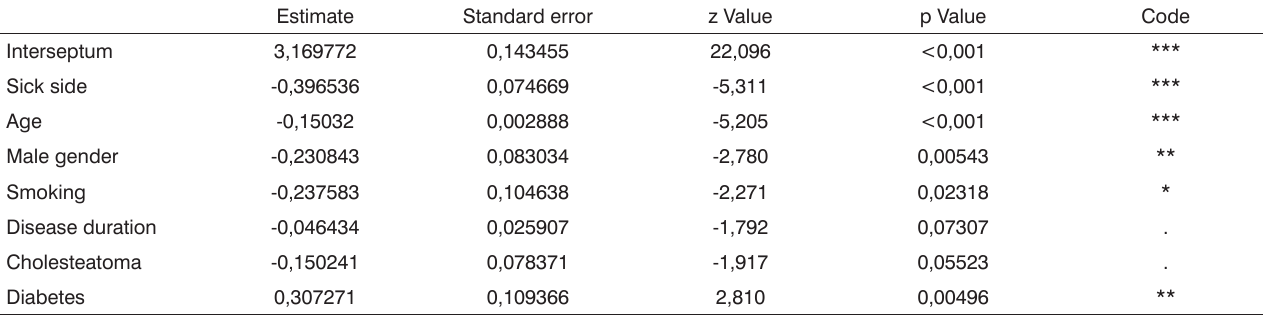
Table 4. Relationship between taste alteration and the different variables analyzed through the Poisson Regression.